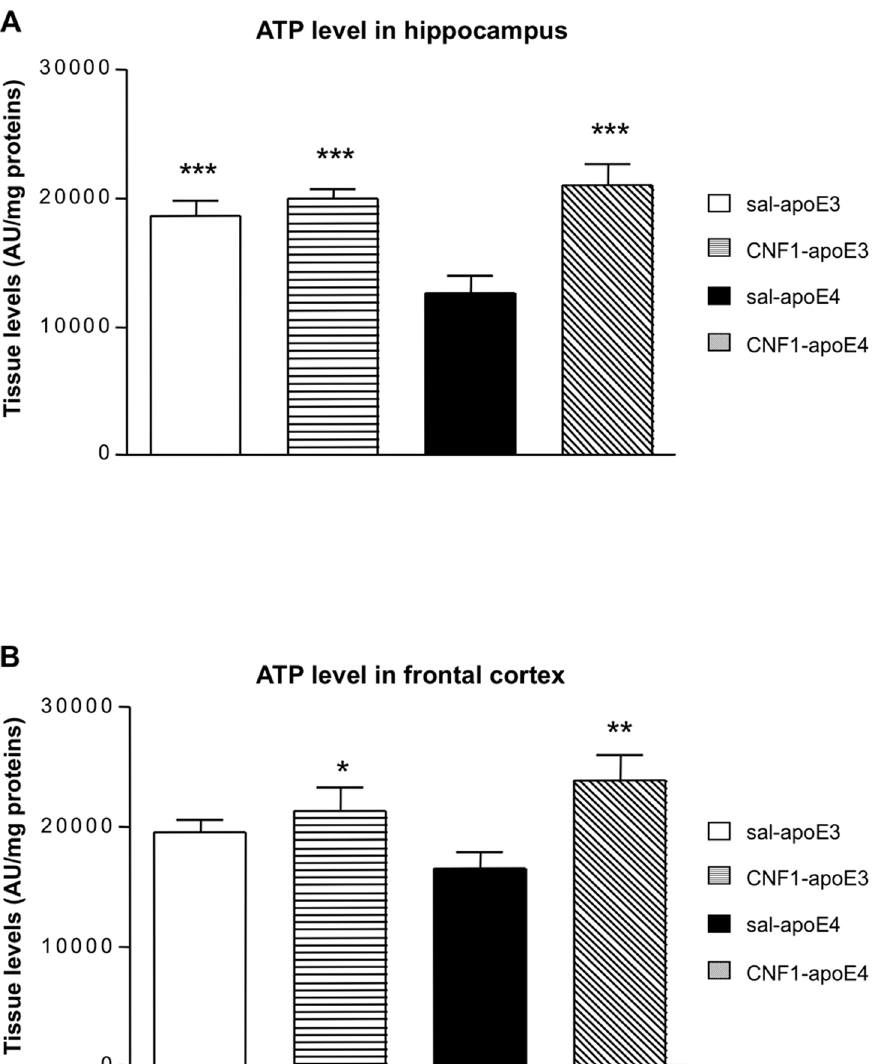
Figure 4. Effect of CNF1 on cerebral ATP levels in apoE4 and apoE3 mice. Hippocampal (Hip, A) and cortical homogenates samples (Cx, B) from apoE3 and apoE4 mice treated with saline or CNF1 were analyzed by ELISA immunoblotting. ATP levels were increased in saline-apoE3, CNF1- apoE4, CNF1-apoE3 mice compared to apoE4 mice (*** p , 0.0001). Data are shown as mean 6 SEM (AU/mg proteins); n=7 per group.